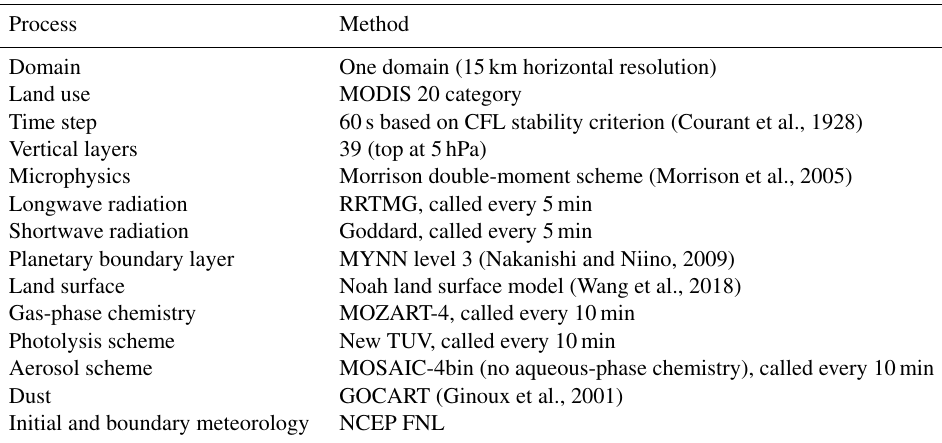
Table 1. Details of WRF-Chem physical and chemical setup configuration.